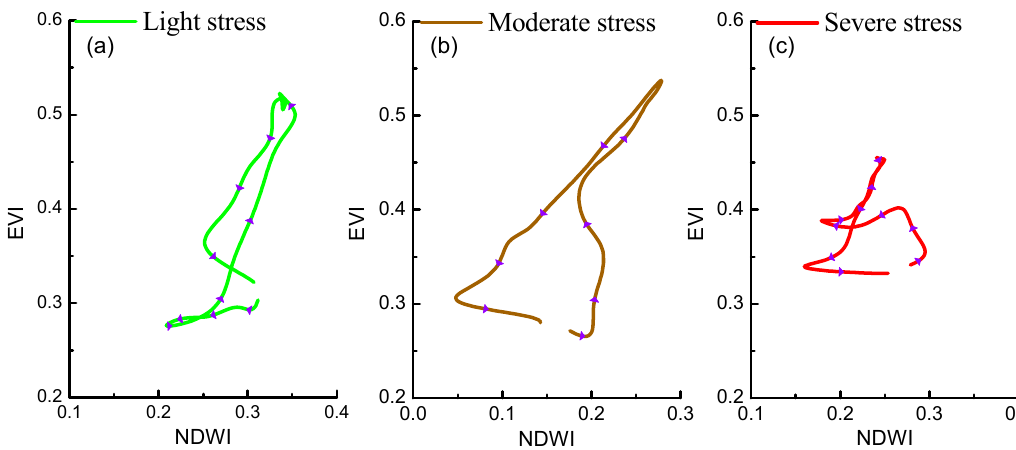
Figure 8. Rice phenological phase spaces of three different heavy metal stress levels (light stress ( a ), moderate stress ( b ), sever stress ( c )). Violet arrows represent the trajectory direction.